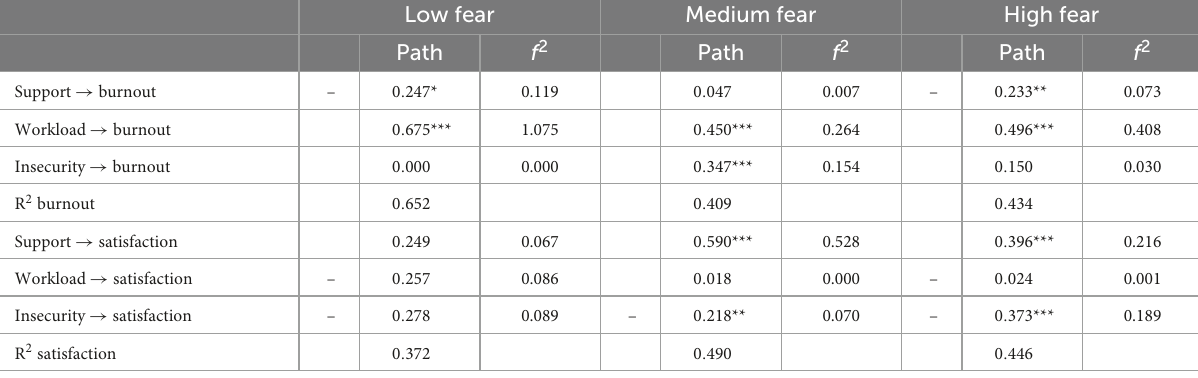
TABLE 3 Results of the multigroup